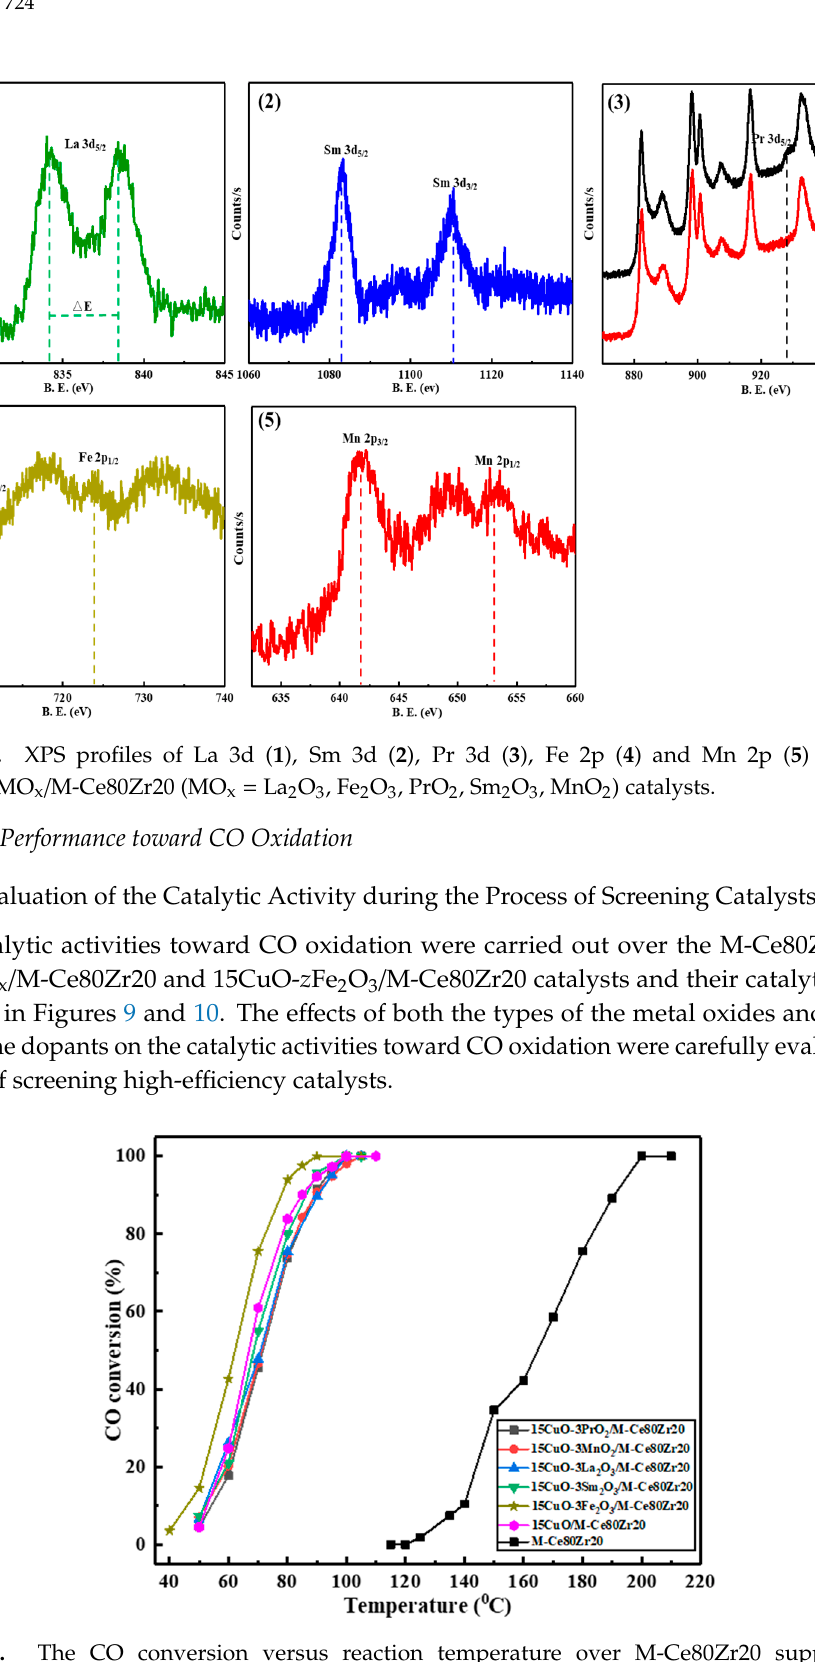
Figure 9. The CO conversion versus reaction temperature over M-Ce80Zr20 support and 15CuO-3MO x / M-Ce80Zr20 (MO x = La 2 O 3 , Fe 2 O 3 , PrO 2 , Sm 2 O 3 , MnO 2 ) catalysts; reaction conditions: 1%CO-20%O 2 -N 2 balance, GHSV = 12000 mL / (g · h), 1 atm.